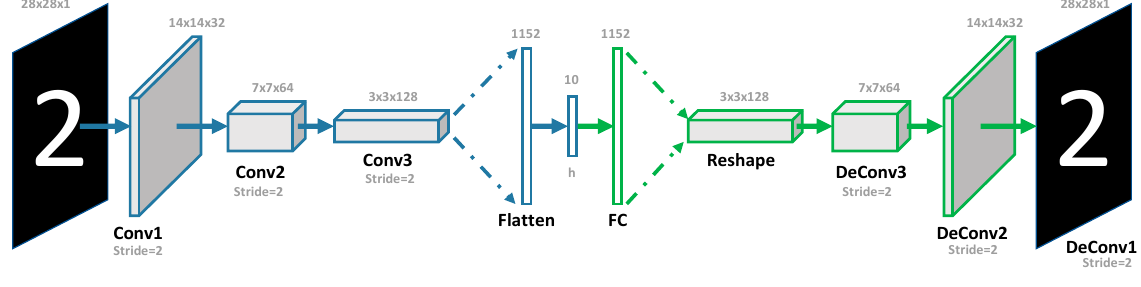
Figure 4. A representation of a convolutional autoencoder